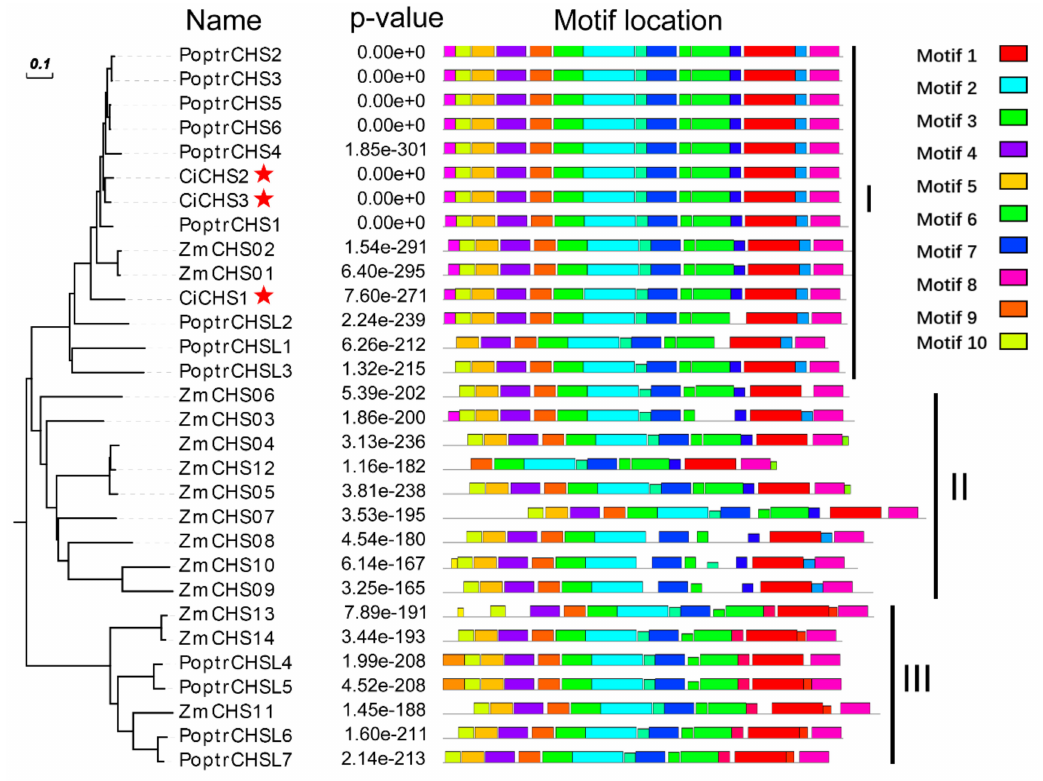
Figure 2. Phylogenetic dendrogram of three amino acid sequences of CiCHSs and CHSs from maize (ZmCHS01~14) and Populus (PoptrCHS1~6, PoptrCHSL1~7) constructed using the neighbor-joining method (1000 bootstrap replications). The conserved motifs in each protein sequence were predicted using the Motif Elicitation (MEME) web server. The red stars show the positions of the three CiCHSs. A multiple sequence alignment of TT4 (AT5G13930), CsCHS2 (P48387.1), CiCHS1, CiCHS2, and CiCHS3 was constructed by using DNAMAN software (Figure 3). CiCHS1 shared 73.25% and 74.75% identity with TT4 and CsCHS2, respectively. For CiCHS2, the identity values were 82.75% (with TT4) and 92.50% (with CsCHS2). In addition, for CiCHS3, the values were 83.00% (with TT4) and 91.75% (with CsCHS2). TT4 encodes a CHS in Arabidopsis , where it regulates flavonoid accumulation and a ff ects plant development and the gravitropism of roots [30]. Tea accumulates much polyphenol in leaves, and CsCHS acts as a rate-limiting enzyme in the flavonoid pathway [31]. Therefore, the high identity of the 3 CiCHSs with TT4 and CsCHS2 implies that they have crucial roles in phenolic